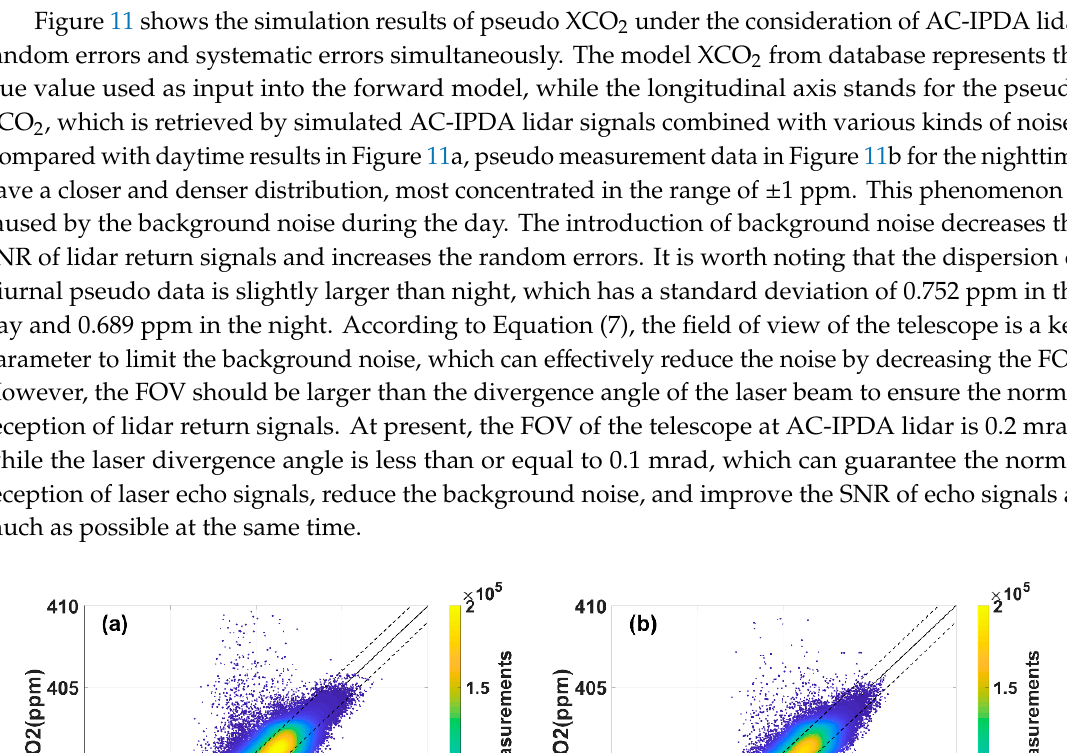
Figure 10. Simulation of global pseudo XCO 2 data of AC-IPDA lidar from 2016/09/01 to 2016/09/16. ( a ) The ‘true’ XCO 2 utilizing CO 2 profiles from CAMS GHG public dataset with IPDA lidar weighting function. ( b ) The pseudo XCO 2 measurements for 16-day orbit repeat cycle in day and night.